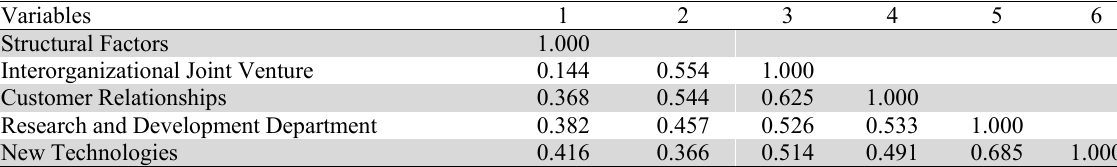
Correlation Matrix of Research Variables Variables